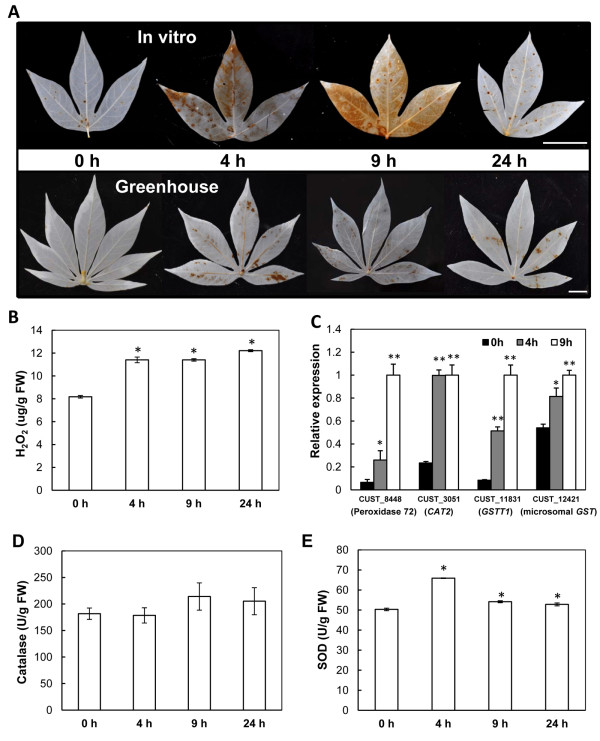
Detection of H2O2, transcript level and enzymatic activities of ROS scavenging genes in cassava subjected to cold (7°C) for 0, 4, 9, and 24 h. (A) DAB polymerization of in vitro and greenhouse-grown leaves subjected to cold. (B) Quantification of H2O2 content in the leaves from the greenhouse-grown plants. (C) The transcript levels of genes encoding for ROS scavenging enzymes in response to cold stress. (D, E) Enzyme activities of catalase and superoxide dismutase (SOD) in the leaves of greenhouse-grown plants. The single and double asterisks indicate a statistically significant difference at p < 0.05 and p < 0.01, respectively, for the data of the stress-treated samples compared to those of the unstressed samples. The mean values are calculated from three biological replicates; the error bars represent the standard error of the mean (SEM). Bar = 1 cm.